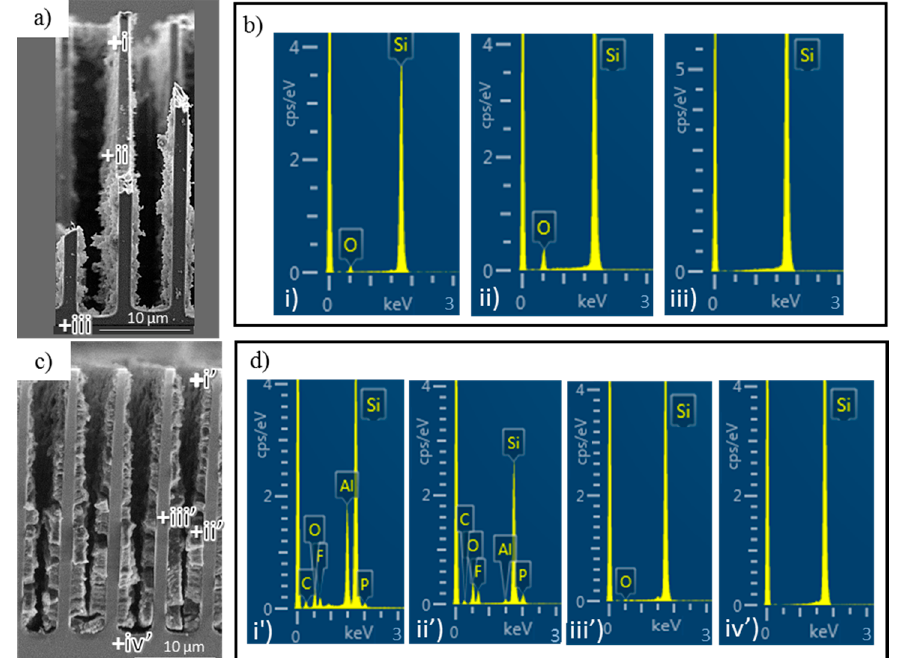
Figure 9. ( a ) SEM image of trenches structures with an aspect ratio of 7 after SiNPs NMP layer deposition, showing cross-section; ( b ) EDX spectra collected from the surface ( i ), the half-height ( ii ) and the wafer Silicon ( iii ); ( c ) SEM image of the same trenches structures (SiNPs NMP) after 500 consecutives galvanostatic cycles at 1 C rate, showing cross-section; ( d ) EDX spectra collected from the surface ( i’ ), the half-height ( ii’ ), the bulk Si ( iii’ ), and the wafer Silicon ( iv’ ).